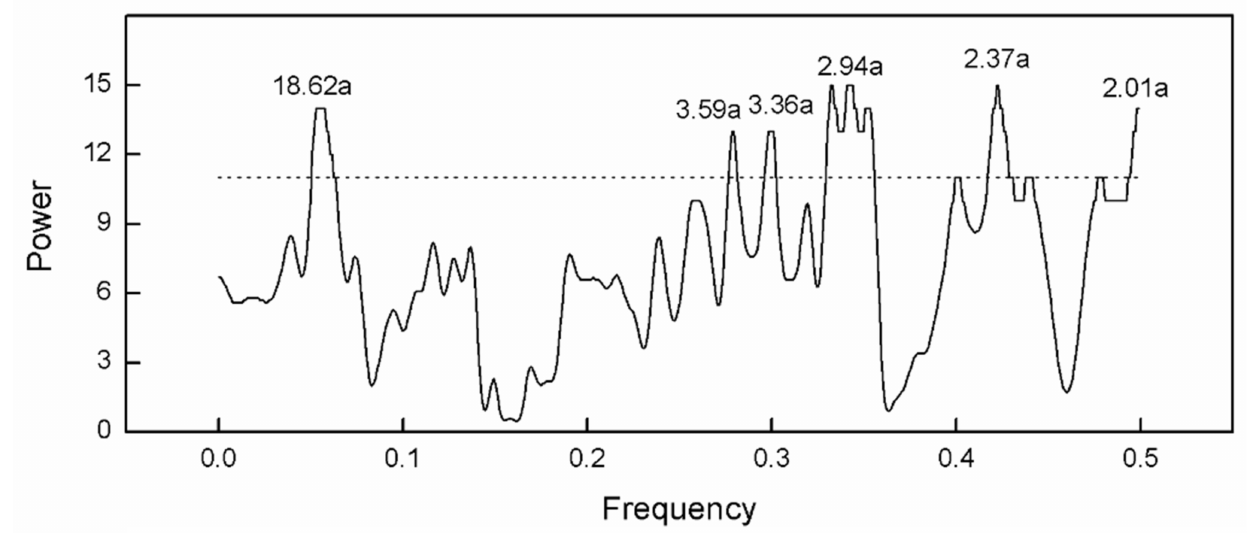
Figure 8. MTM spectral density of the reconstruction. The dashed line represents the 90% confidence level. a: